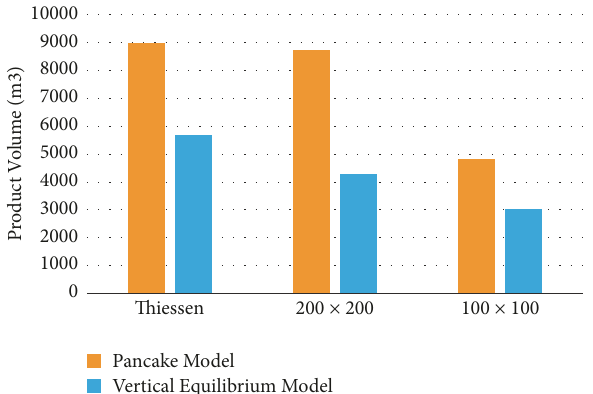
Figure8:Comparisonbetweenproductvolumesestimatedthrough Pancake Model and Vertical Equilibrium Model using Thiessen polygons and grid at square regular mesh (100 × 100, 200 ×